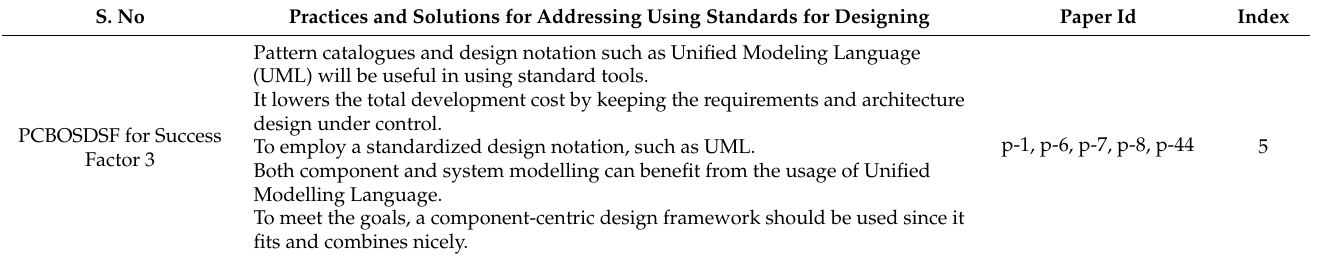
Table 7. CBOSDSF 3: Using standards for